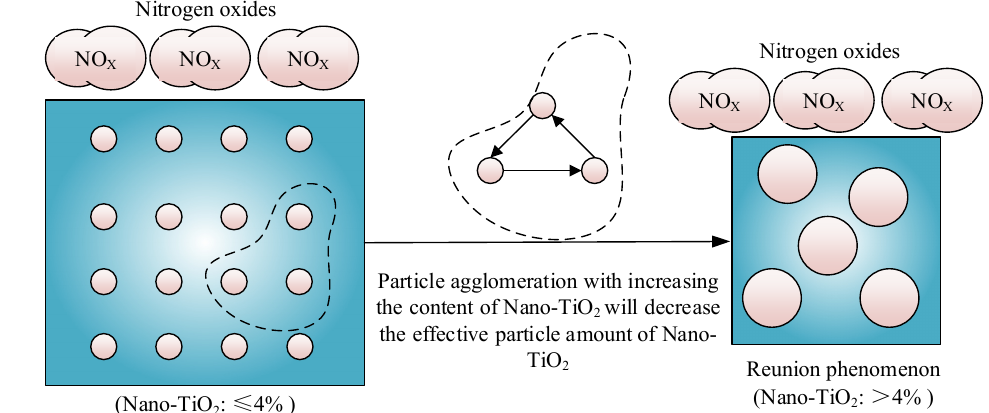
Figure 8. Nano-TiO 2 agglomeration for decreasing the catalytic